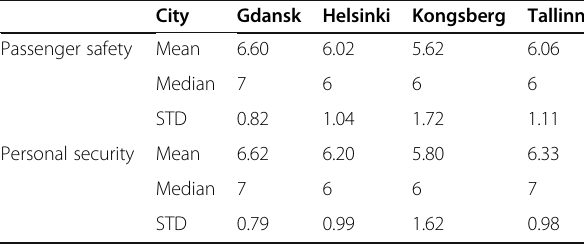
Table 4 Mean, median and standard deviation values passenger safety and personal security scores given the score for each pilot city (scale from 1 -lowest to 7 -highest) City Passenger safety Mean